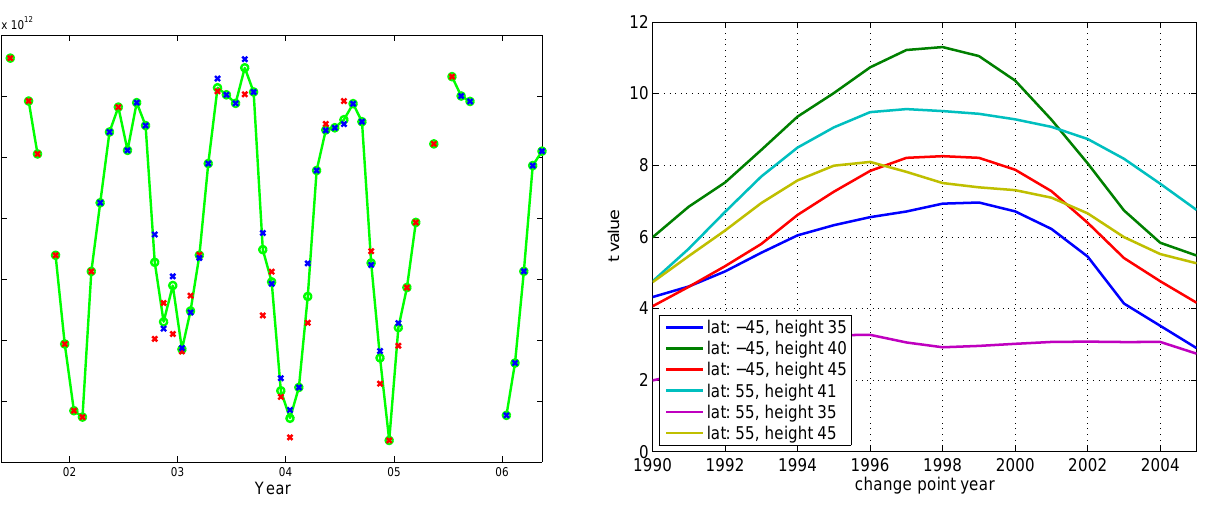
Fig. 10. An example of the combined SAGE II and GOMOS data sets at 30km between 40–50 ◦ N. Red crosses indicate SAGE II data, blues crosses indicate GOMOS data, and the green line with circles indicates the combined data (gaps in the line are due to missing data).